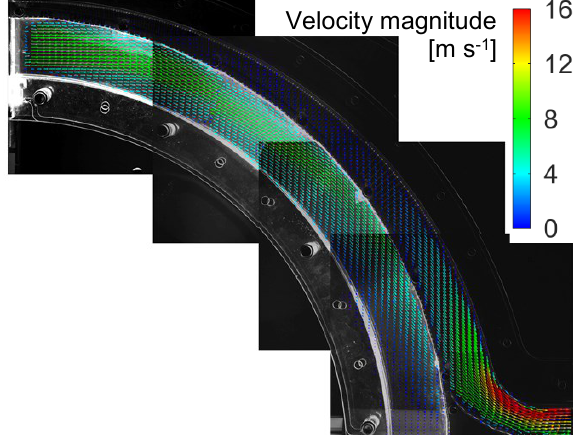
Fig. 3. Velocity vector field coloured by velocity magnitude for mean velocity of 5.7 m/s .